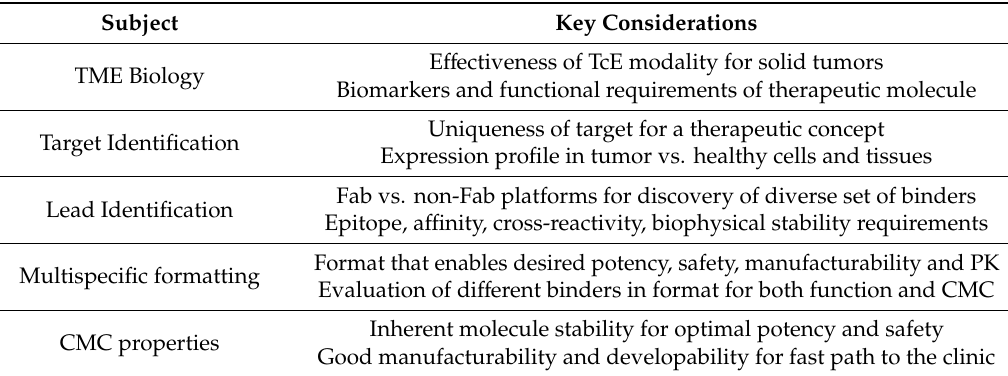
Table 2. Discovery strategy to benefit identification and evaluation of TcEs for solid